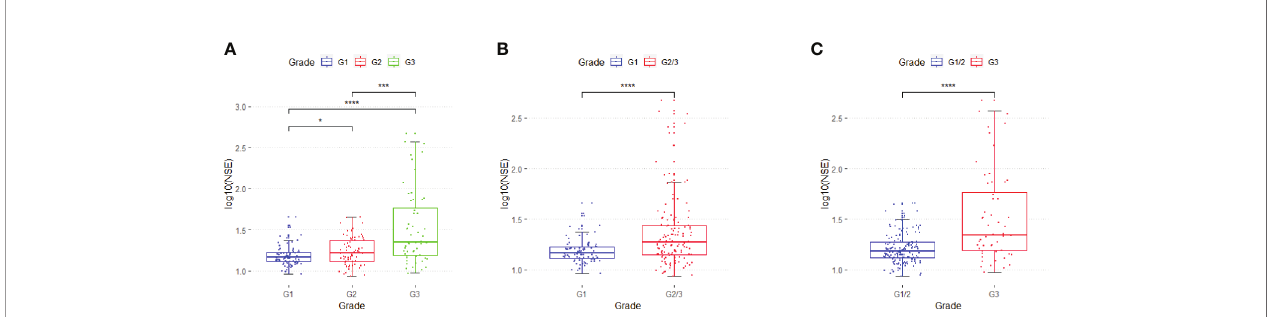
FIGURE 1 | The distribution of serum NSE in different grades of GEP-NETs. (A) The serum NSE levels in G1, G2 and G3. (B) The serum NSE levels in G1 and G2/ 3. (C) The serum NSE levels in G1/2 and G3. (*p < 0.05; ***p < 0.01; ****p < 0.0001).